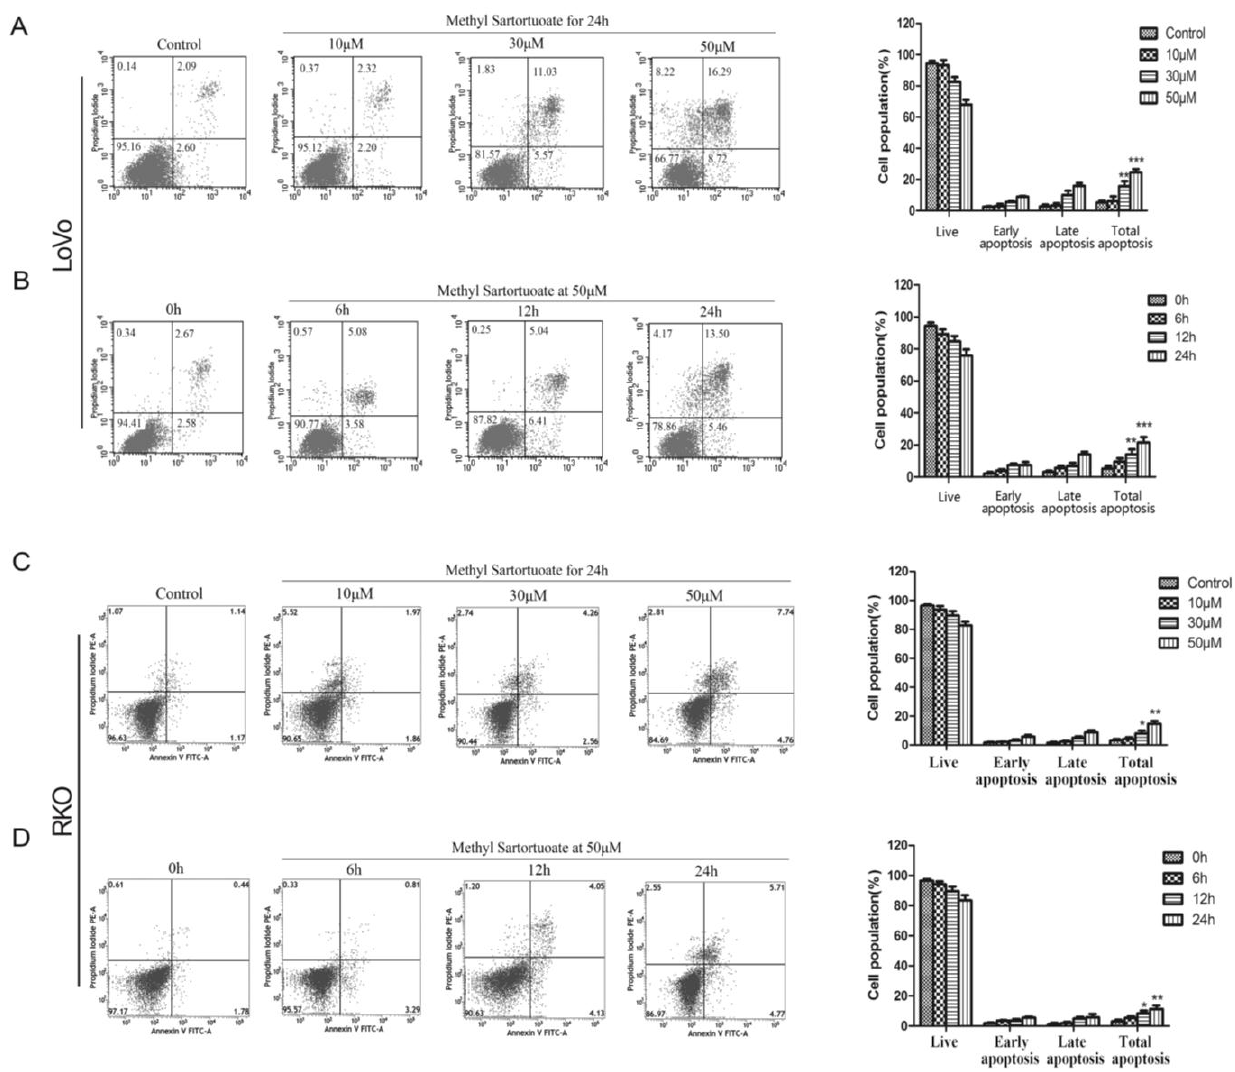
Figure 2. The apoptotic effects of Methyl Sartortuoate in LoVo and RKO cells. ( A , C ) Dose-and-effect results of Methyl Sartortuoate treated LoVo and RKO cells. LoVo and RKO cells were treated with Methyl Sartortuoate at the indicated concentration for 24 h. Apoptosis was examined by the annexin V flow cytometric assay method ( n = 3). The percentage of apoptotic cells was scored after cell exposure to Methyl Sartortuoate. * p < 0.05, ** p < 0.01, *** p < 0.001 versus control group; ( B , D ) Time-and-effect results of Methyl Sartortuoate-treated LoVo and RKO cells by the annexin V flow cytometric assay method ( n = 3). LoVo and RKO cells were treated with Methyl Sartortuoate at 50 µM for 0, 6, 12 and 24 h. The percentage of apoptotic cells were scored after cell exposure to Methyl Sartortuoate for the indicated time at 50 µM. * p < 0.05, ** p < 0.01, *** p < 0.001 versus 0